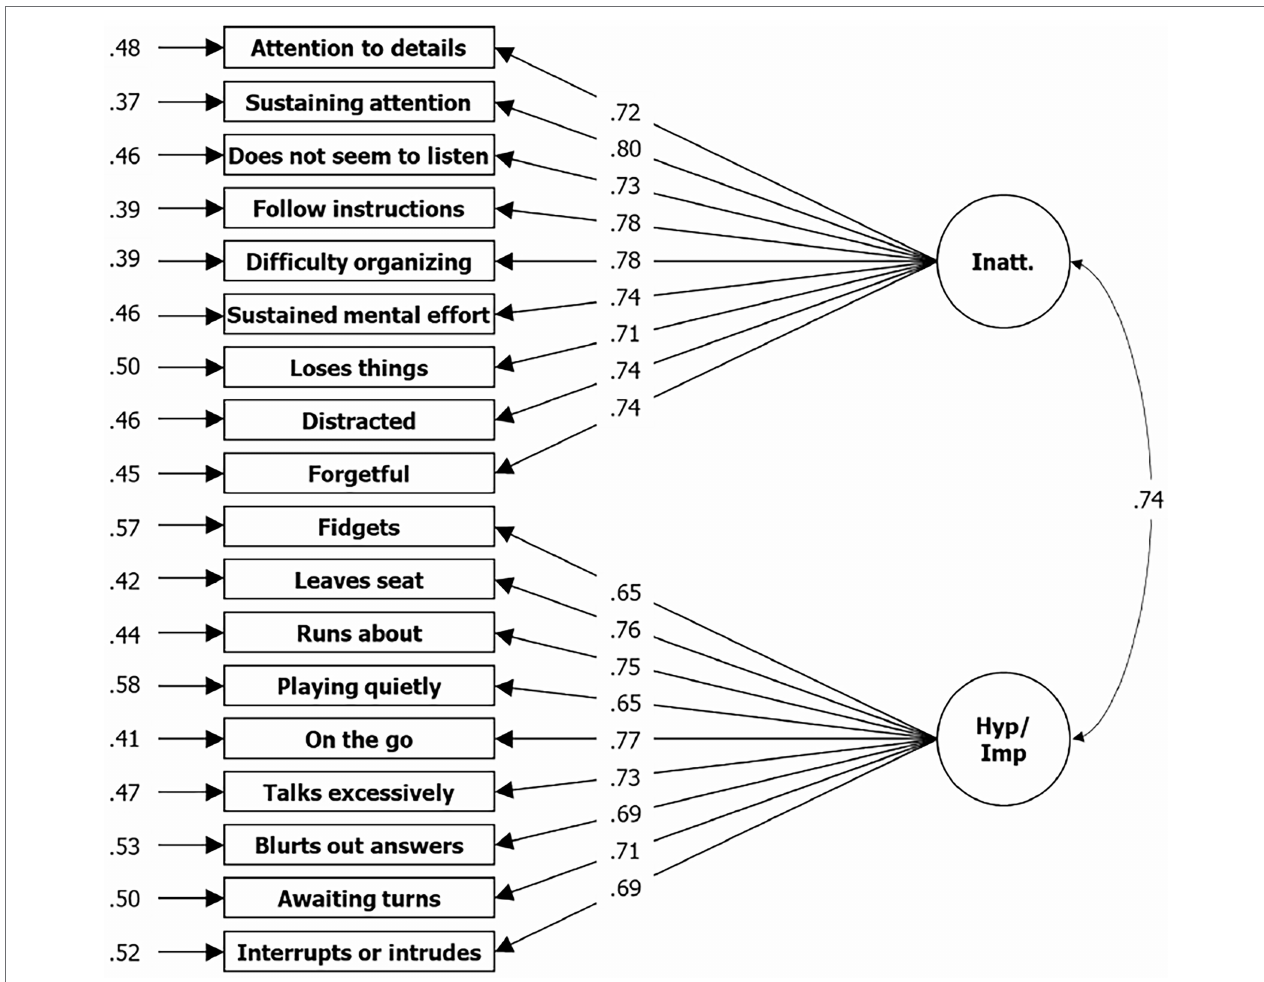
FIGURE 1 | Results from CFA for two factor solution based on symptom items of the ADHD Rating Scale—5. N = 3,736; Loglikelihood user model (H 0 ) = − 58729.958; Fits: χ 2 [135] = 2135.909, CFI = 0.946, TLI = 0.939, RMSEA = 0.063, SRMR = 0.037; left = residual variances, center = factor loadings (lambda), right =